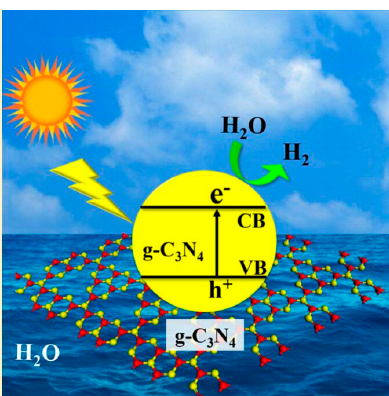
Figure 5. Proposed mechanism of graphitic carbon nitride (g-C 3 N 4 )-based photocatalysts. Reproduced with permission from Reference [72]; copyright (2014), American Chemical Society.